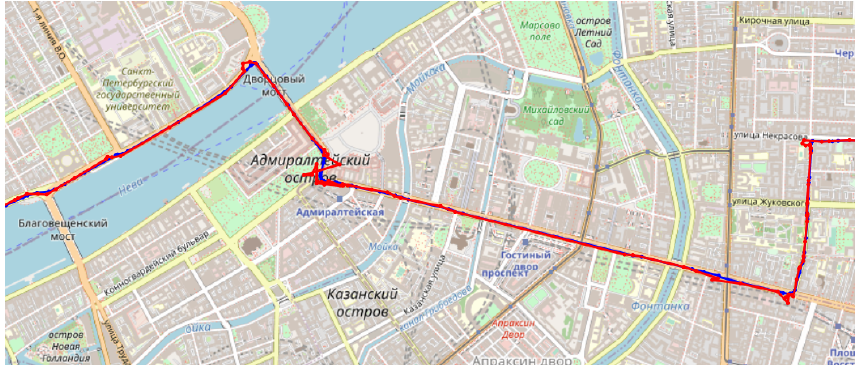
Figure 7. Actual and predicted tourist